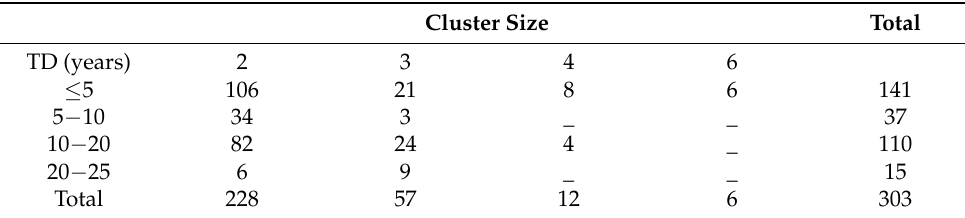
Table 1. Shows the distribution of linked HIV sequences according to cluster size and